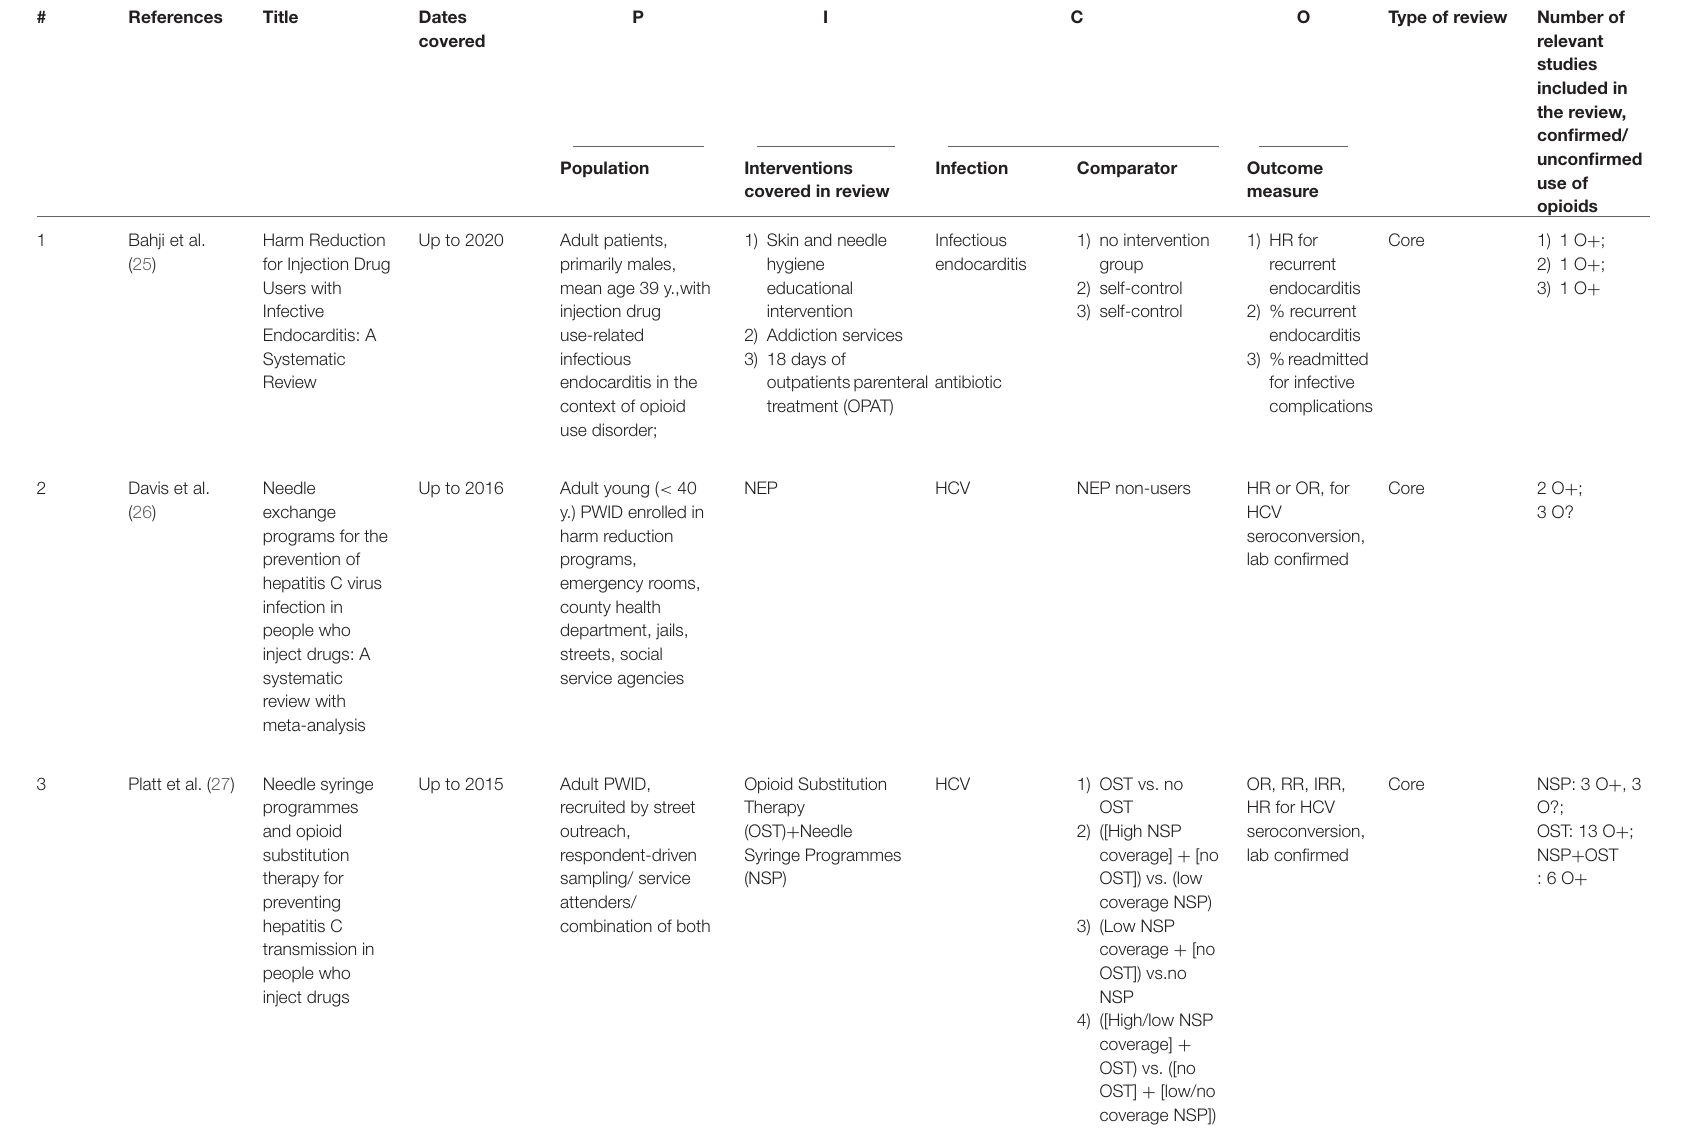
TABLE 4 | Summary of core and supplementary reviews of the effectiveness of interventions for preventions of common infections in opioid users.